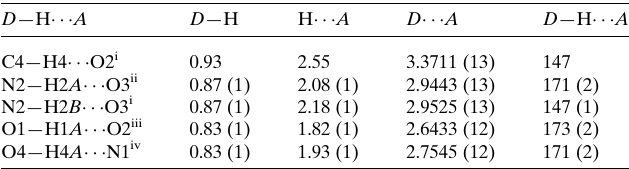
Table 1 Hydrogen-bond geometry (A˚ , (cid:4) ).